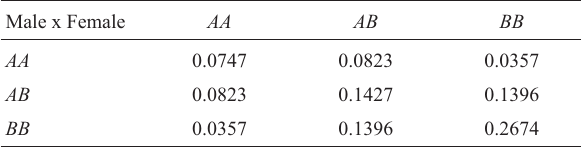
Table 1 - Mating scheme with α = 3, β = 5, ω = 1/8, χ = 1/2.